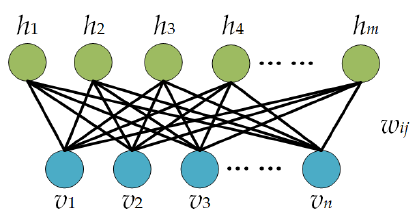
Figure 1. Structure of RBM.